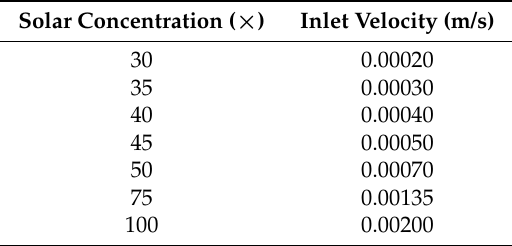
Table 4. Inlet velocities for solar